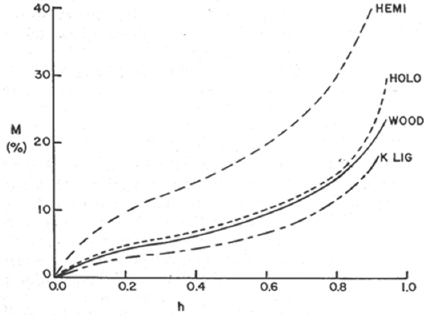
Figure 2. Sorption Isotherms for wood and cell wall polymers [5].